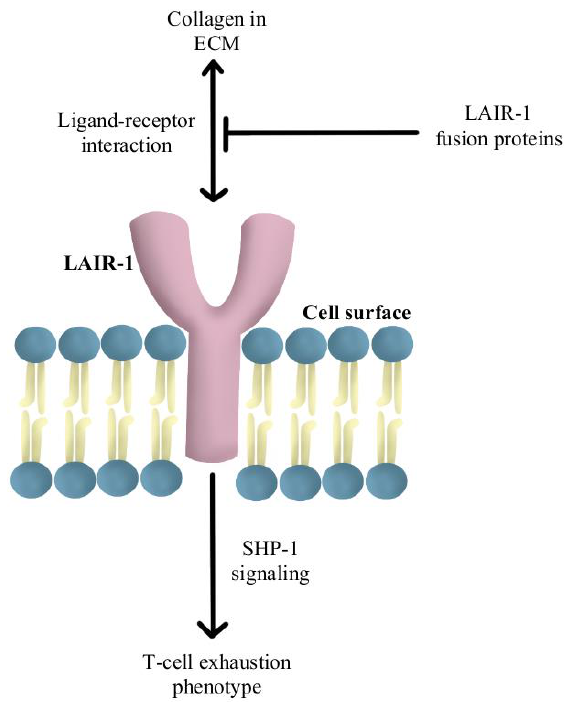
Figure 5. Diagram of LAIR-1 pathway modulation [85–87]. Illustrated by Kaitlyn Mi of The Dart- mouth Institute.